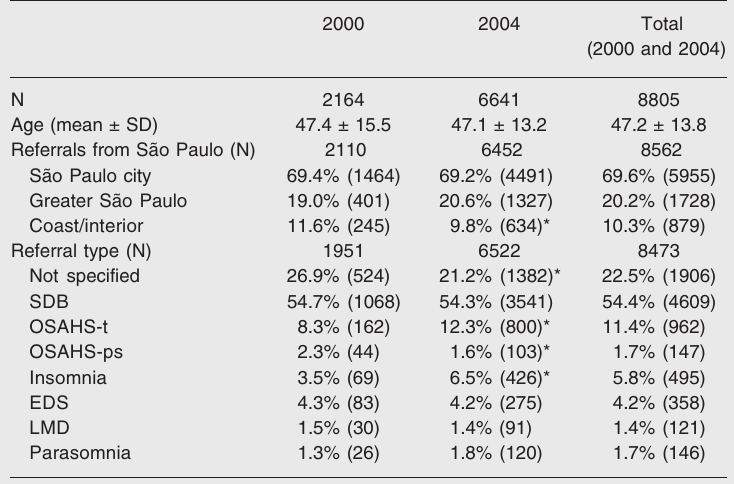
Table 3. Comparison of patient characteristics of the Sleep Institute before (2000) and after (2004) an outreach information